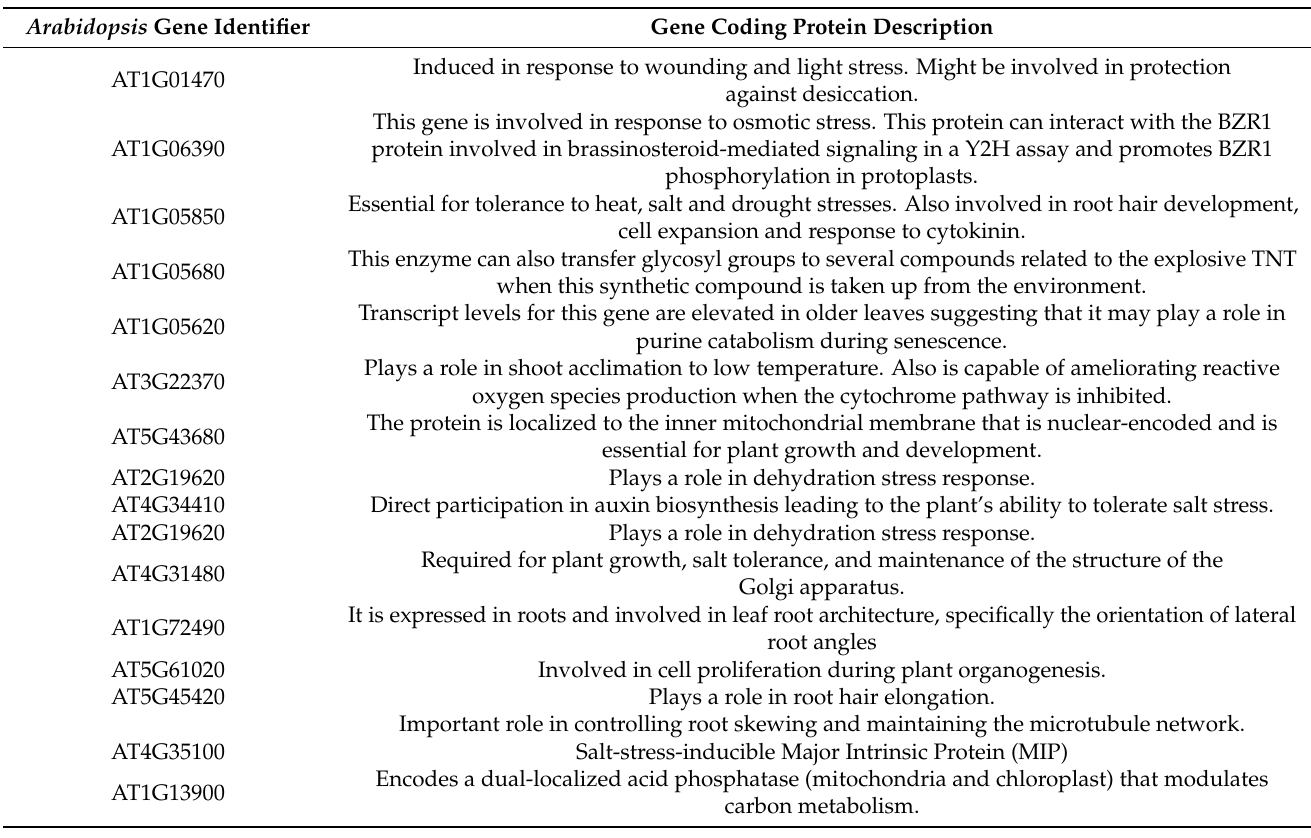
Supplementary Table S2. Gene names for the ATG numbers for hub genes and authority genes